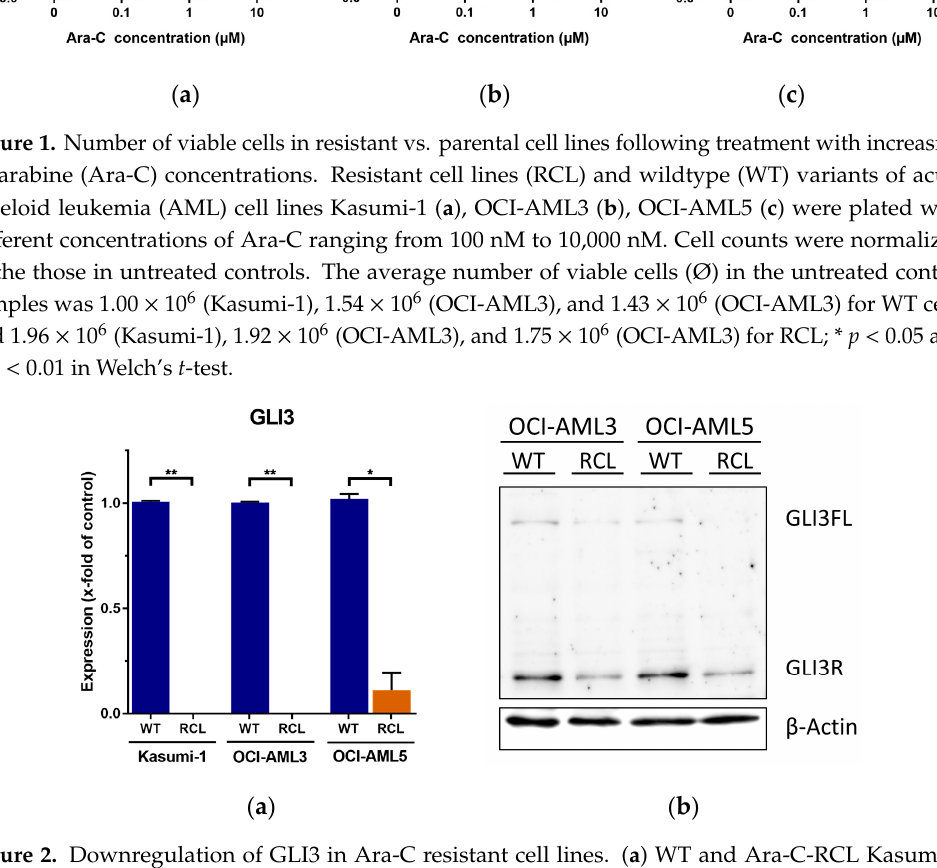
Figure 3. Efficiency of GLI3 knockdown in AML cell lines THP-1 and OCI-AML3. GLI3 mRNA levels were measured by RT-qPCR following lentiviral transduction with two distinct shRNA targeting GLI3 . The expression of GLI3 was normalized to that in control cells transduced with a scrambled control shRNA; * p < 0.05 and ** p < 0.01 in Welch’s t -test.